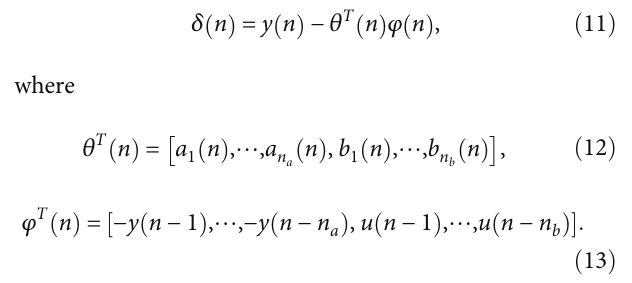
Figure 3: H ∞ feedback controller design by